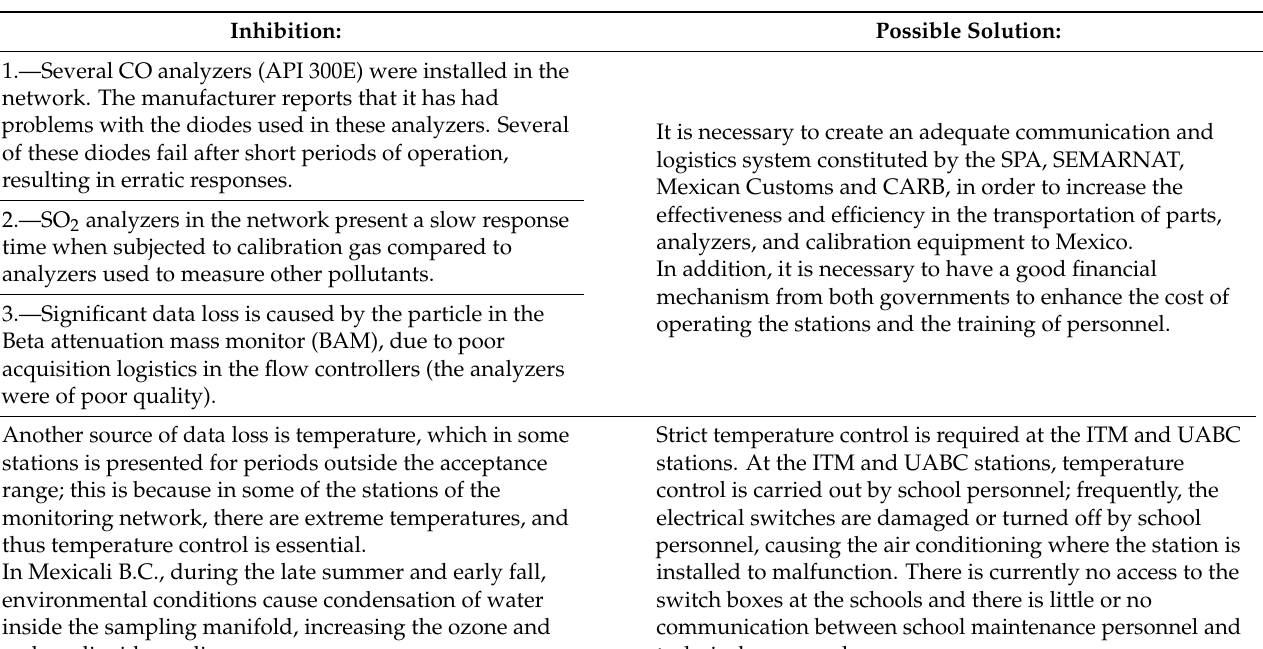
Table 1. Inhibitions and solutions for the daily recording of air monitoring stations in Mexicali